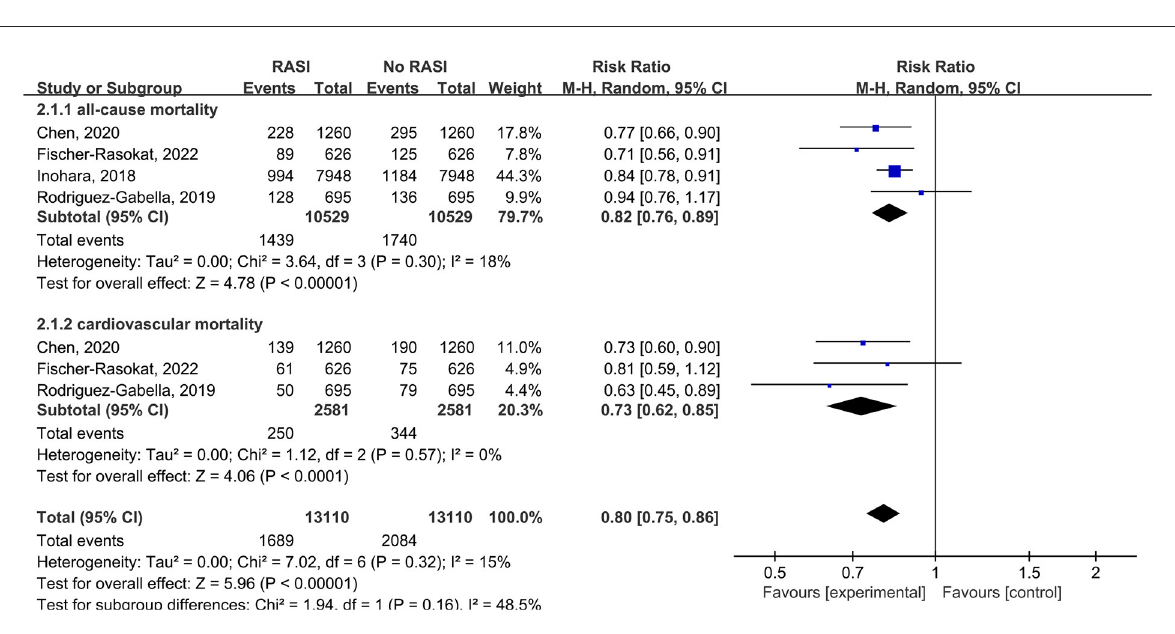
TAVR. For reduction of mortality and reverse remodeling, two studies have demonstrated that the impact of RAS inhibitors was dose-dependent. The results demonstrated that RAS inhibitors with ≥ 50% target dose were more effective than < 50% target dose, and there was no significant difference between a full 100% target dose and a 50% target dose. It seems that RAS